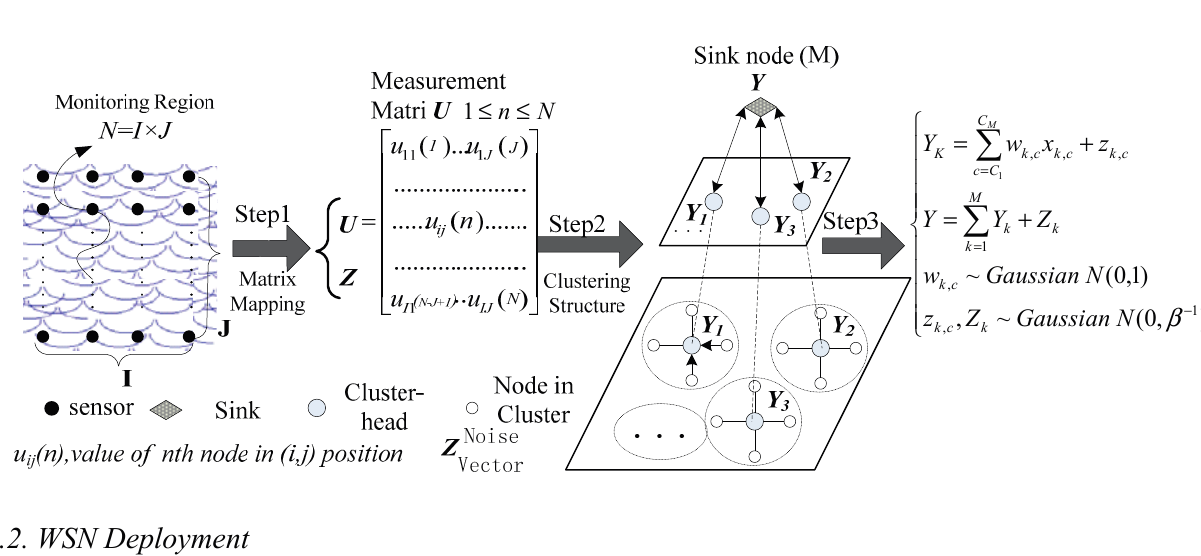
Figure 1. HRM_CS